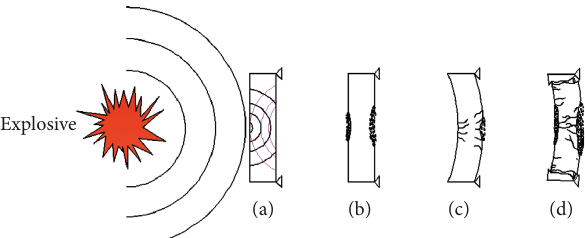
Figure 6: Blast response of RC member: (a) transmission of stress wave; (b) local damage points; (c) global flexural failure; (d) global direct shear failure.